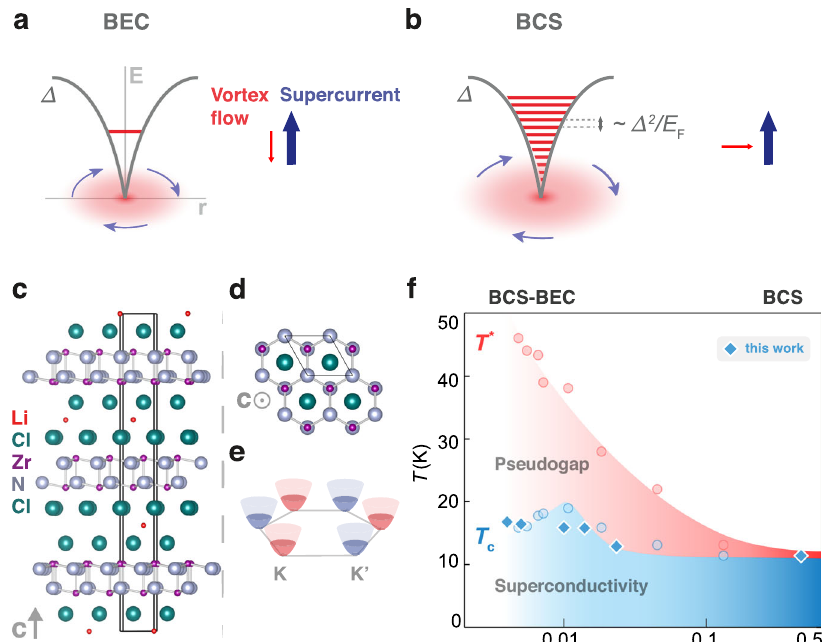
Fig.1|PropertiesofsuperconductingLi x ZrNCl.a , b Caroli-de Gennes-Matricone (CdGM) schematic of the quantized state(s) in the vortex core in the BEC a and BCS limit b are depicted. The vortex core is shaded in red, and the axis labels E and r correspond to energy and distance, respectively. The directions of super- current and vortex fl ow are indicated. In the BEC limit, the vortex motion is dissipationless and the vortex fl ow is nearly anti-parallel to the supercurrent, while in the BCS limit the vortex motion is nearly perpendicular to the super- current. Side c and top d view of the Li x ZrNCl crystal structure. The solid black